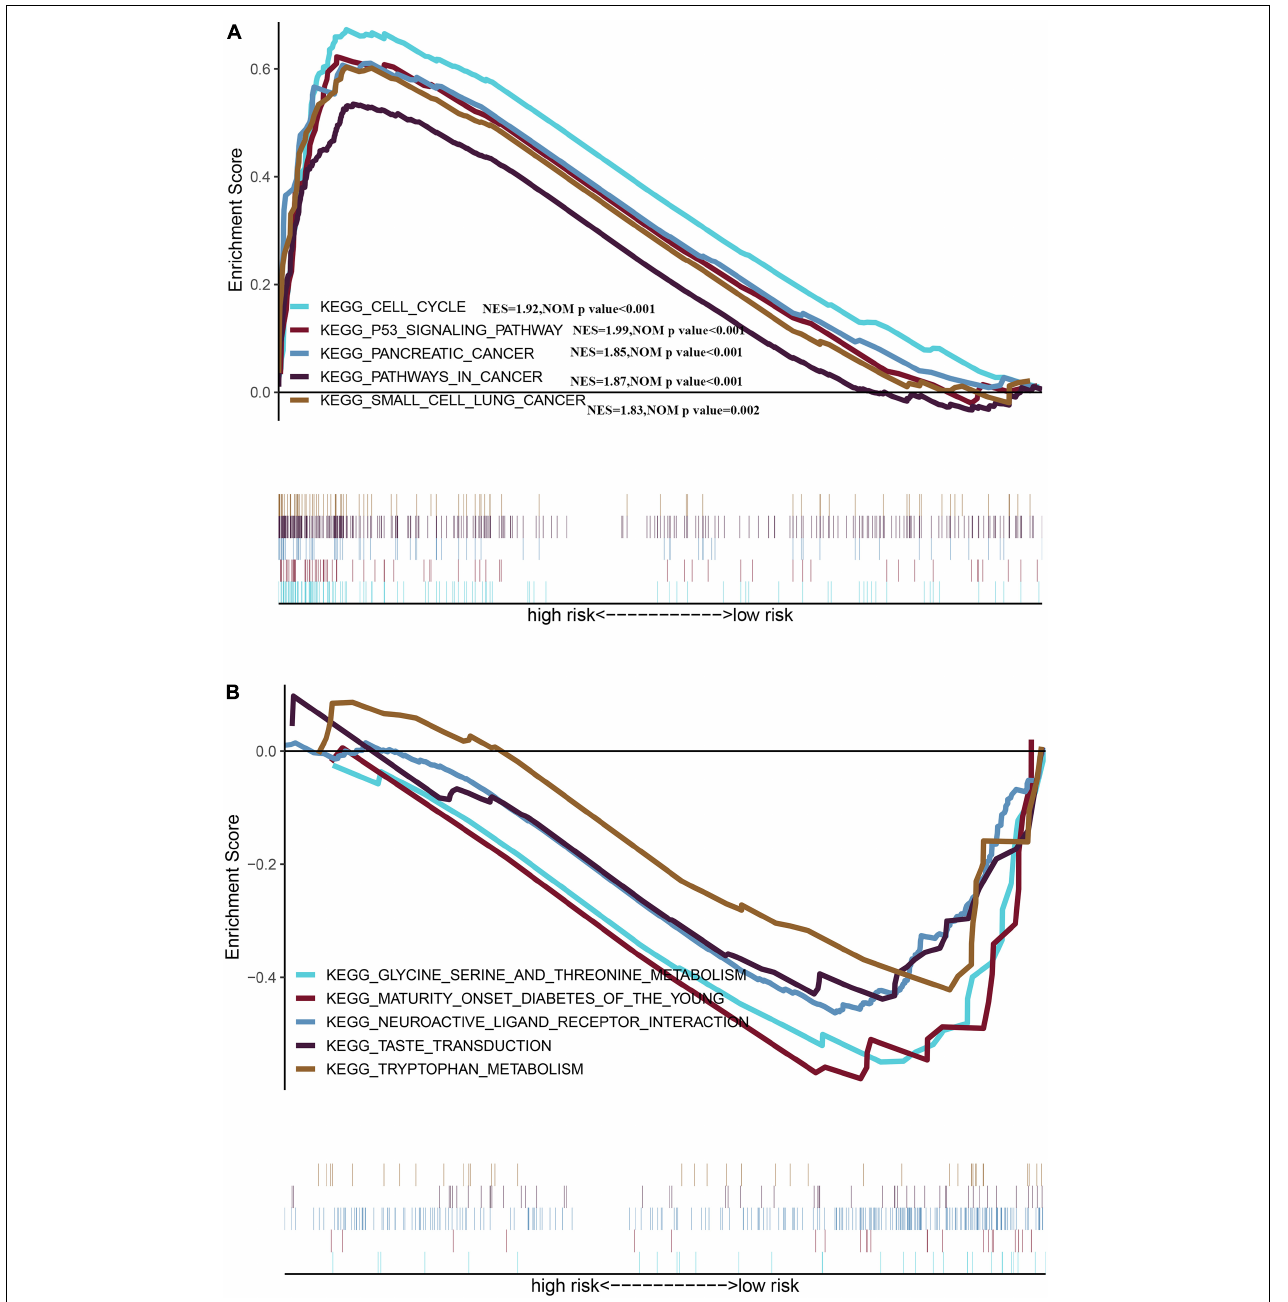
FIGURE 8 | Gene Set Enrichment Analysis between different risk groups (A) Multiple GSEA plot of the KEGG pathways enriched for the high-risk group. (B) Multiple GSEA plot of the KEGG pathways enriched for the low-risk